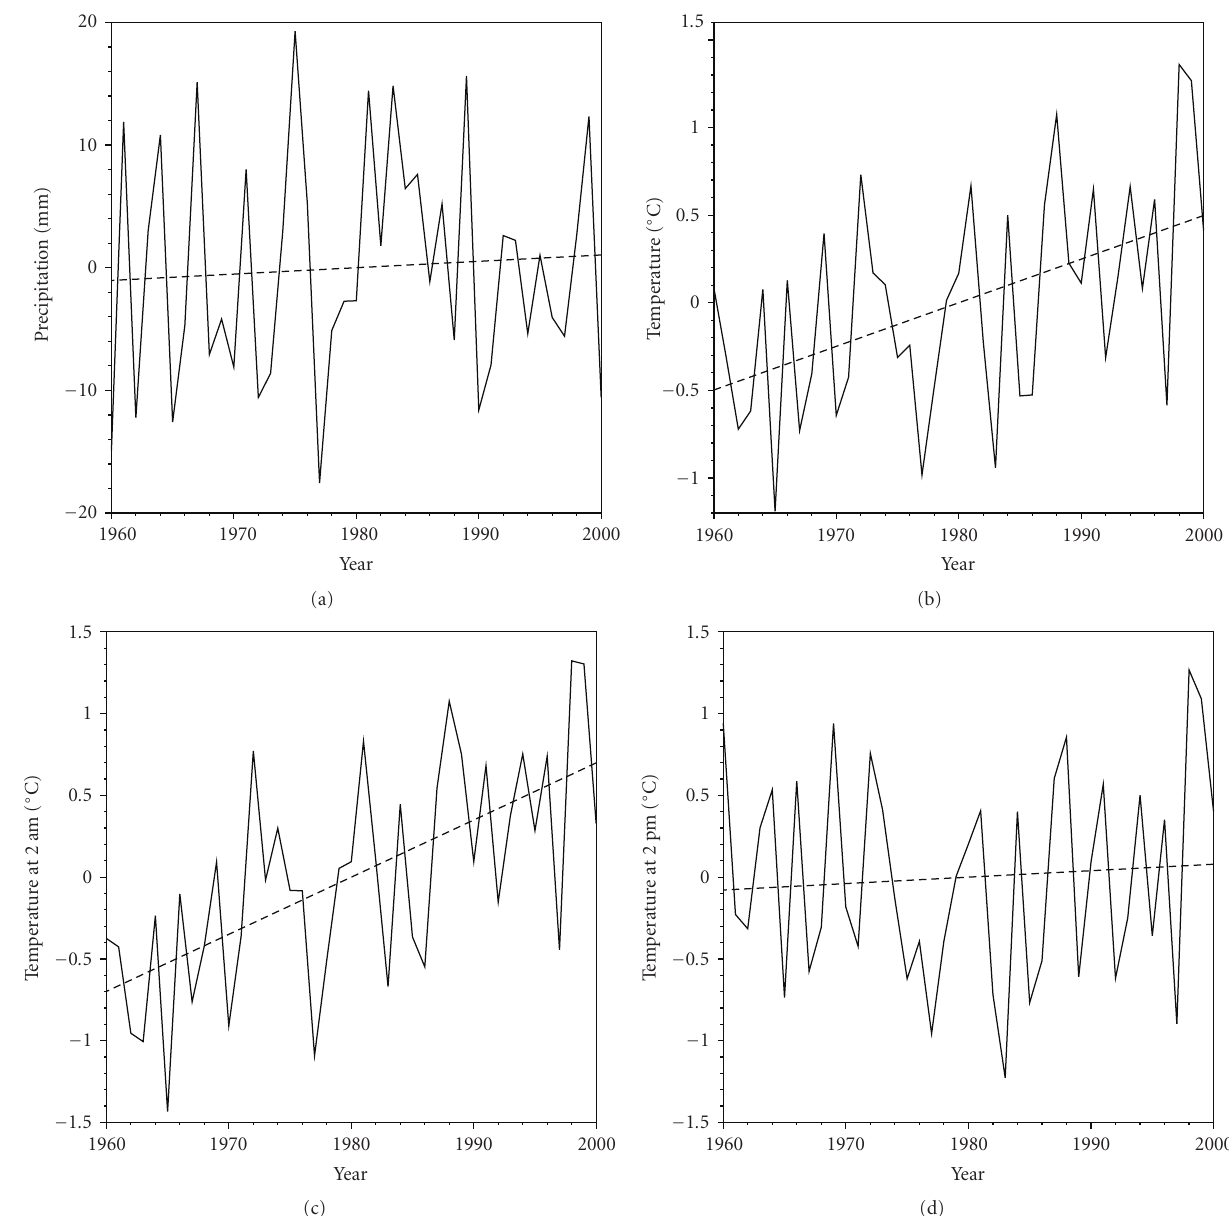
Figure 3: The time series of annual precipitation and temperature anomalies at the Xinghai station. (a) Precipitation (mm); (b) temperature ( ◦ C); (c) temperature at 2 AM ( ◦ C); temperature at 2 PM. The dashed line in each figure represents the